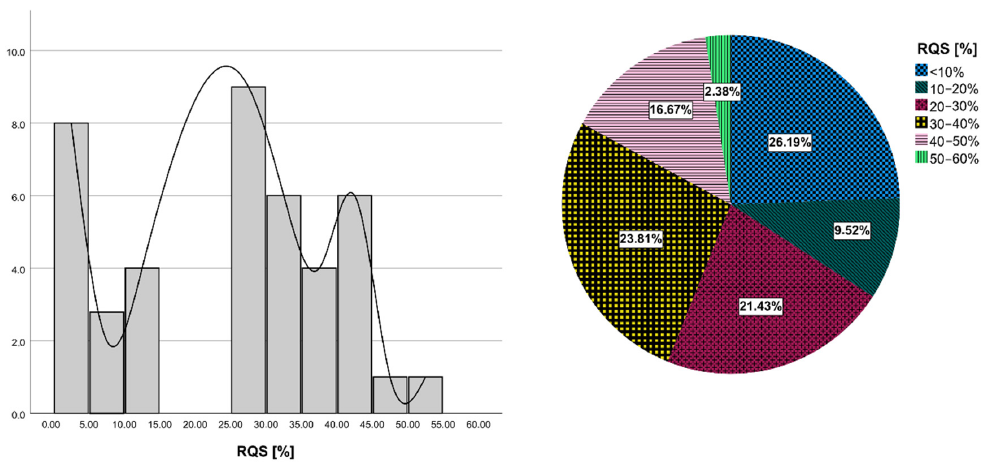
Figure 2. Results of RQS assessment. Histogram plot of row counts of included studies according to RQS percentage (on the left ). Pie chart of the mean RQS of included studies.